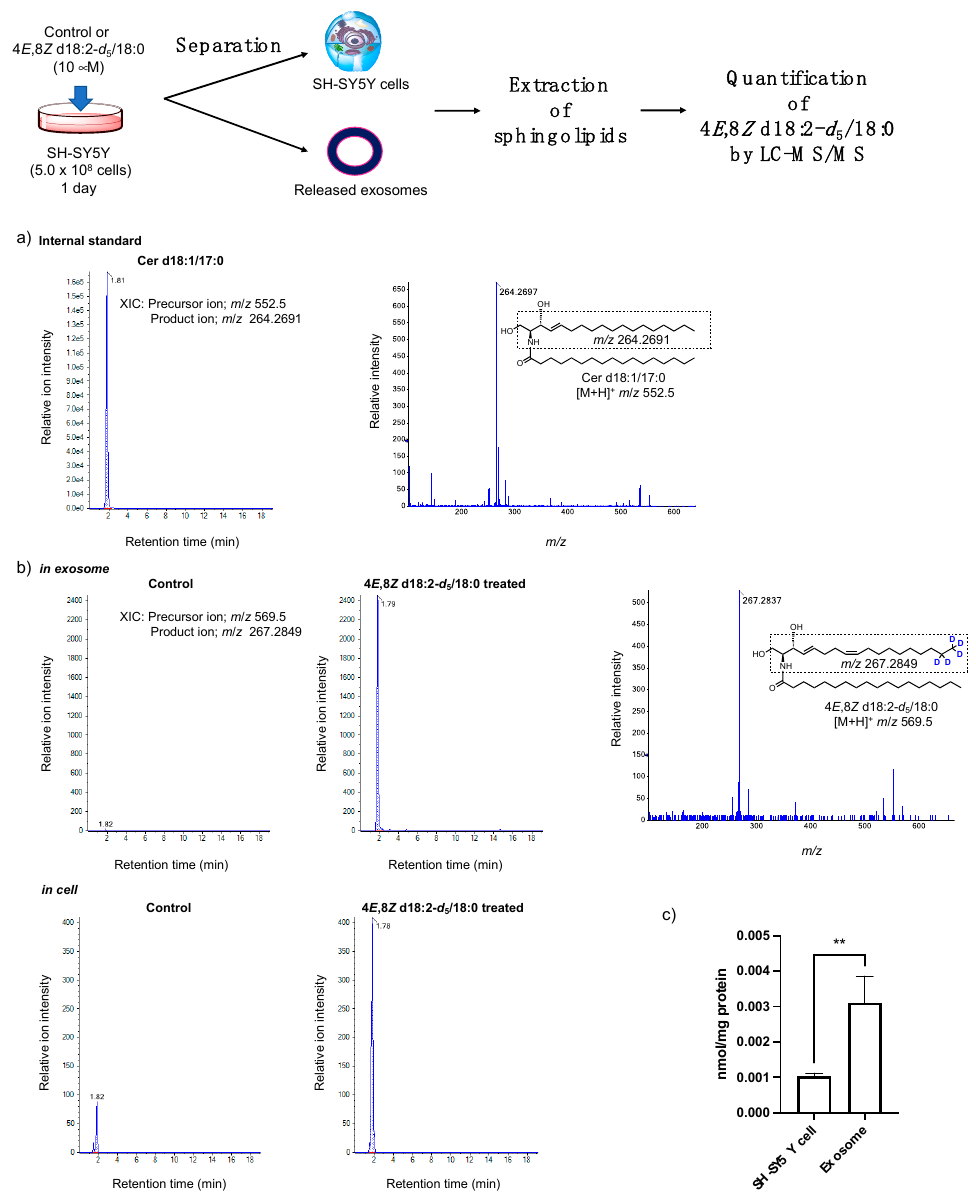
Figure 7. ( a ) Extracted ion chromatogram (XIC) and product ion spectrum for the product ion ( m / z = 264.2691) of Cer d18:1/17:0 ( m / z = 552.5). ( b ) XIC and product ion spectrum of Cer 4 E ,8 Z d18:2- d 5 /18:0 ( m / z = 569.5) clearly showing the product ion m / z = 267.2849 (4 E ,8 Z d18:2- d 5 ) in exosome. ( c ) Quantities of 4 E ,8 Z d18:2- d 5 /18:0 in SH-SY5Y cells and exosomes treated for 24 h. Results were represented as the mean ± SD ( n = 3; ** p < 0.01).